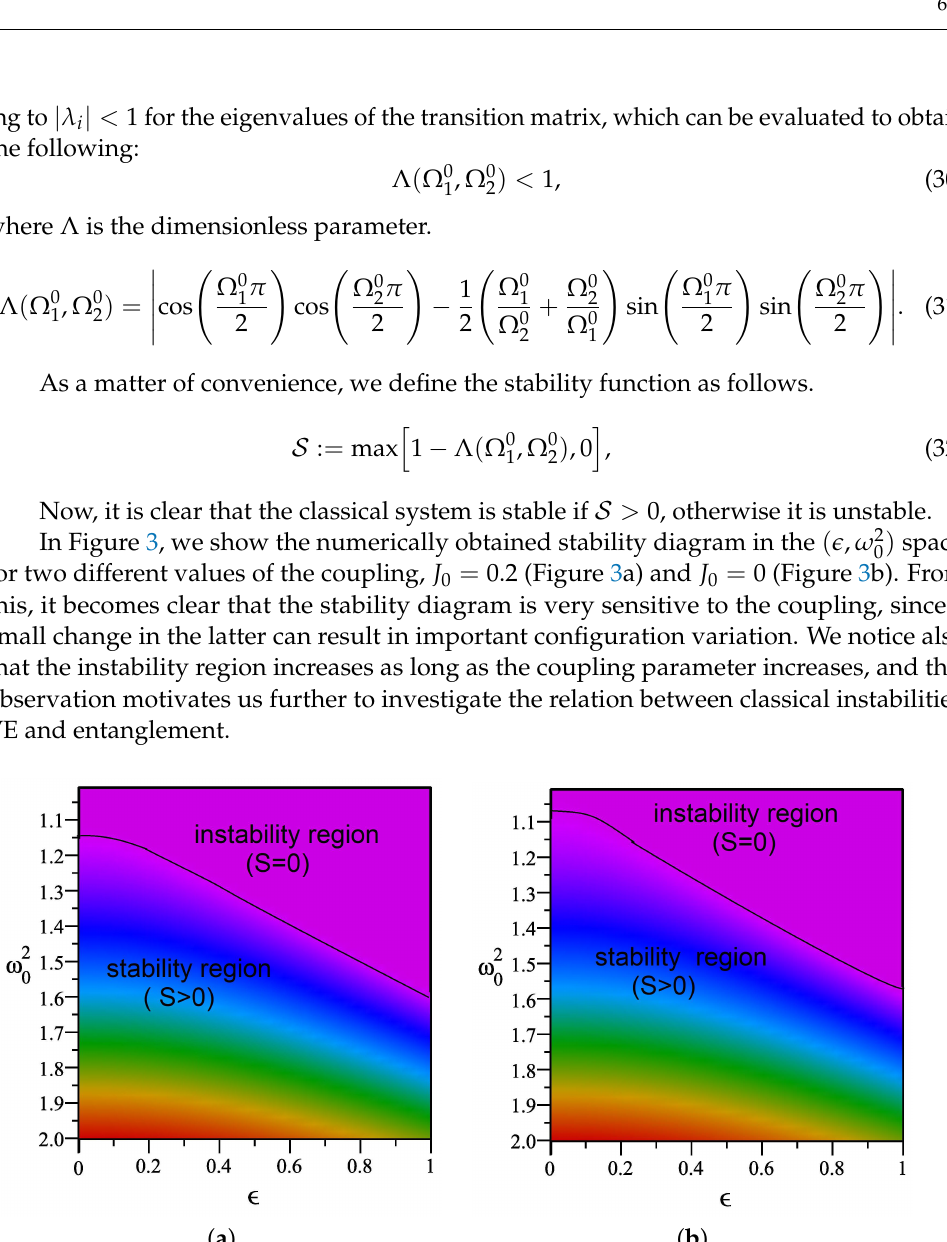
= 0.2 and ( b ) J = 0. The upper area 0 0